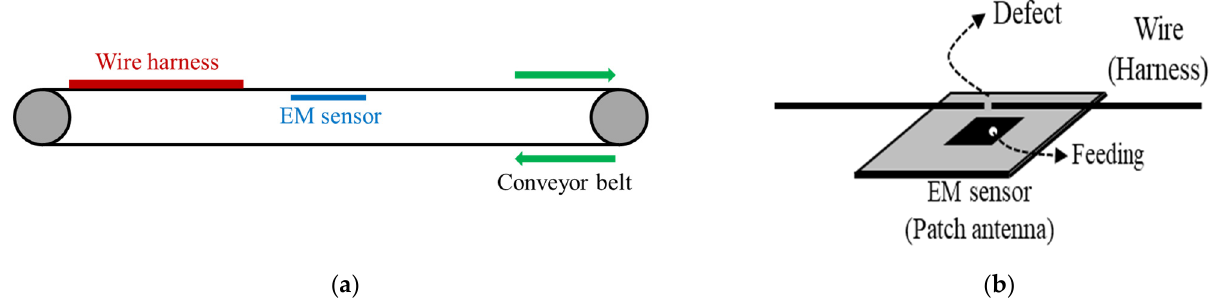
Figure 1. EM sensor for non-contact detection of defective wire harness. ( a ) Conveyor system. ( b ) Wire harness above the EM sensor. ( b ) Wire harness above the EM